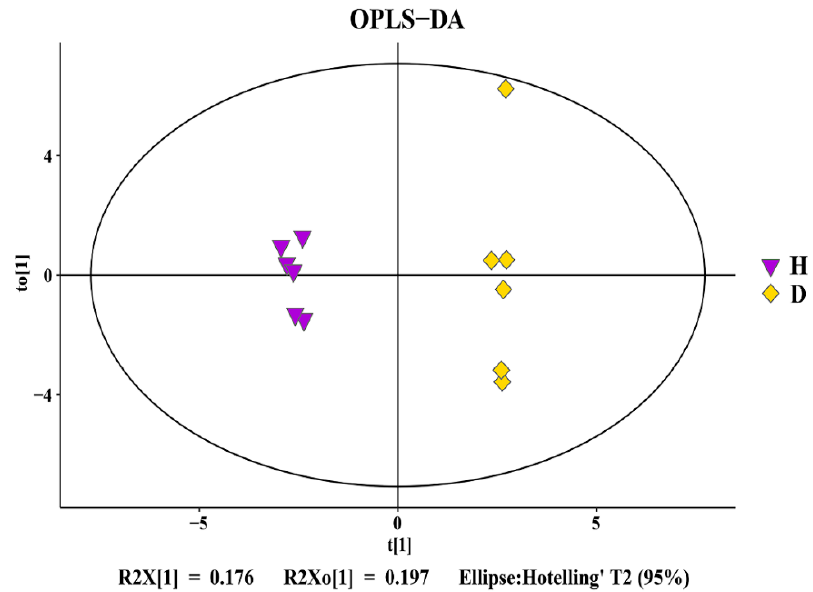
Figure 5. OPLS-DA score map of healthy (H) and diseased (D) bayberry rhizosphere soil.